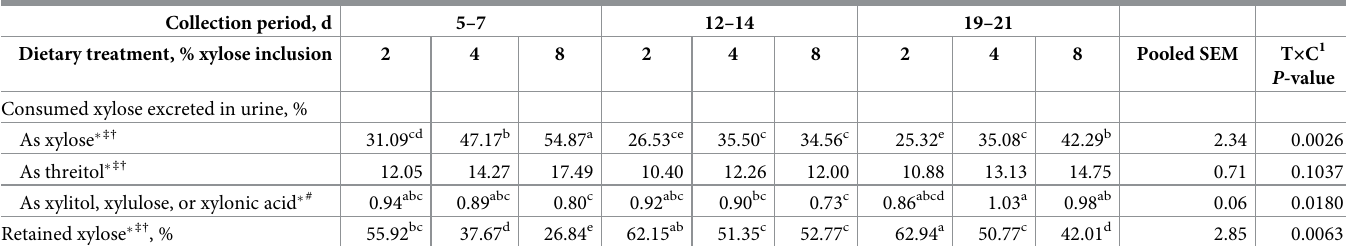
Table 8. Effect of dietary xylose concentration and collection period on urine energy concentration and urine sugar concentration and excretion. Collection period,